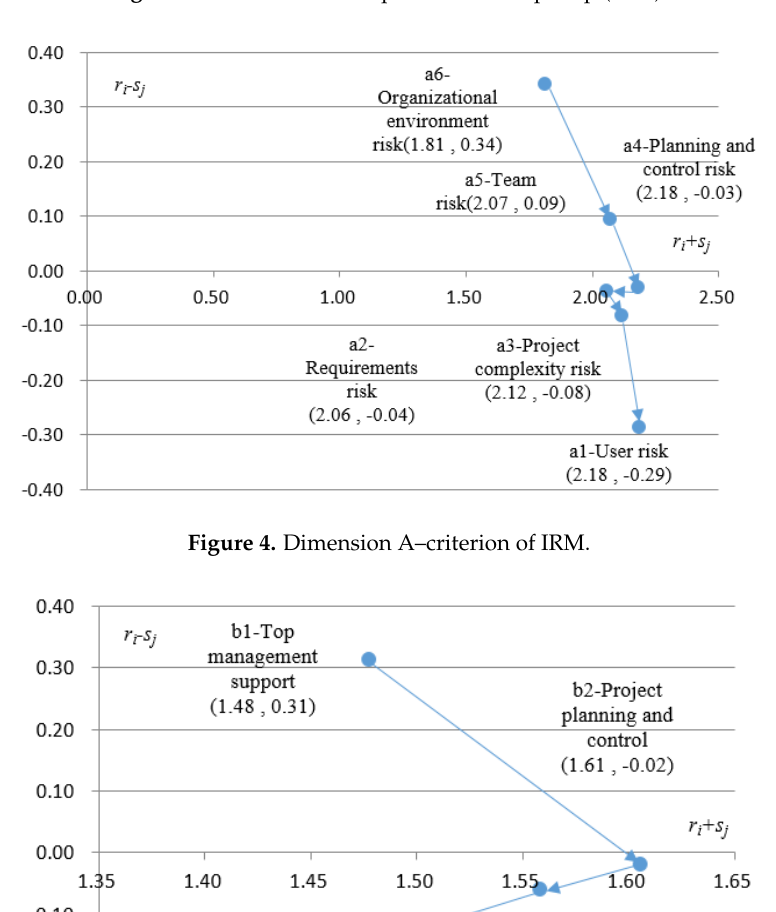
Figure 3. Dimensions of impact relationship map (IRM). ISPRS Int. J. Geo-Inf. 2016 , 5 , 227